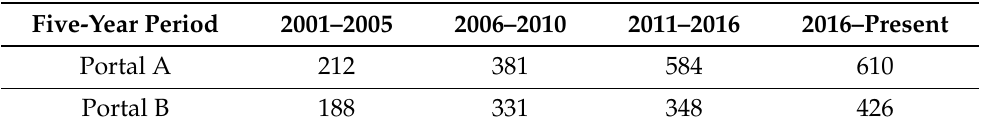
Table 1. Number of academic documents related to PID control for industrial processes that were published in the past twenty years and indexed in the academic document portals.